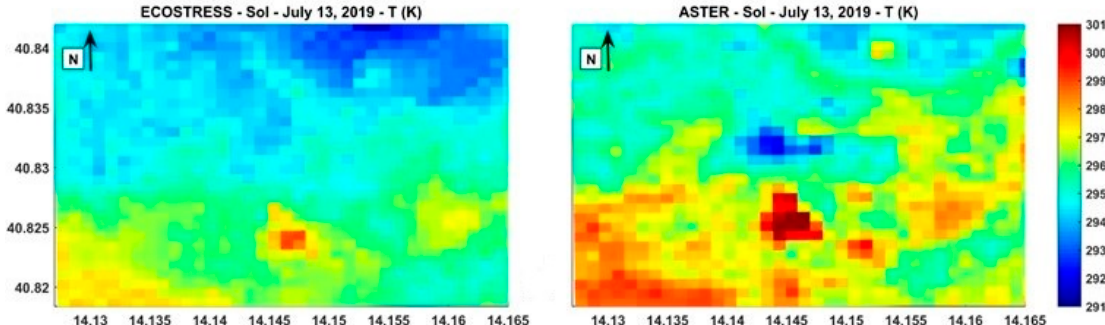
Figure 3. Surface temperature estimates of ECOSTRESS ( left ) and ASTER data ( right ) on Solfatara site. North is aligned with the vertical axis and the pixel size is 90 m.